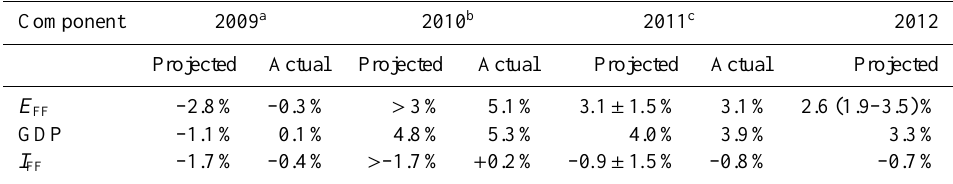
Table 5. Actual CO 2 emissions from fossil fuel combustion and cement production ( E FF ) compared to projections made the previous year based on world GDP and the fossil fuel intensity of GDP ( I FF ). The “Actual” values and the “Projected” value for 2012 refer to those presented in this paper.